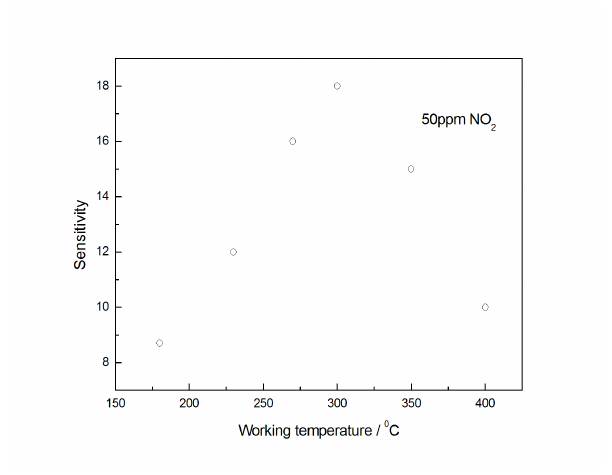
Figure 3 . The temperature-sensitivity curves of ITO thin